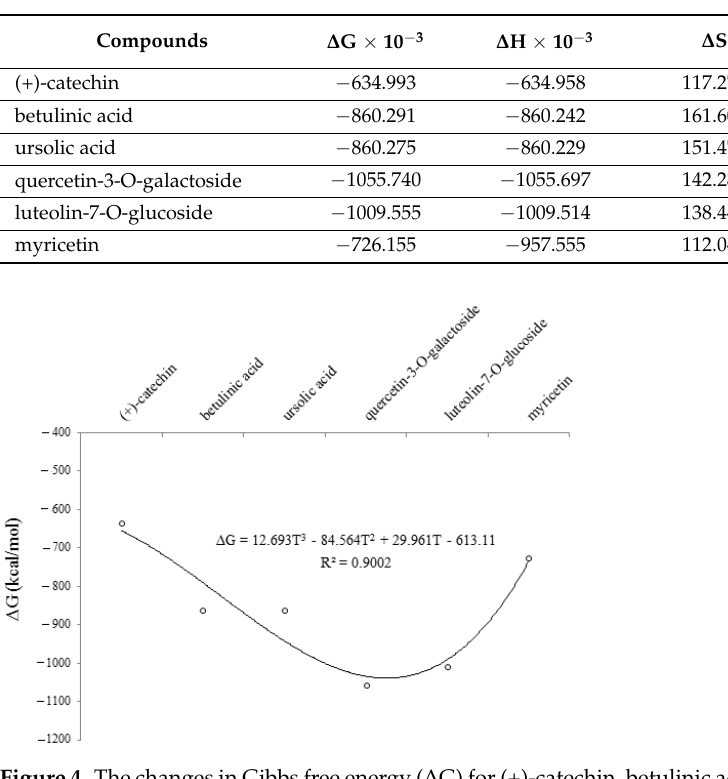
Table 2. The results of calculated thermodynamic properties of ∆G, ∆H (kcal/mol) and ∆S (cal/mol.K −1 ) in water at 300 K.